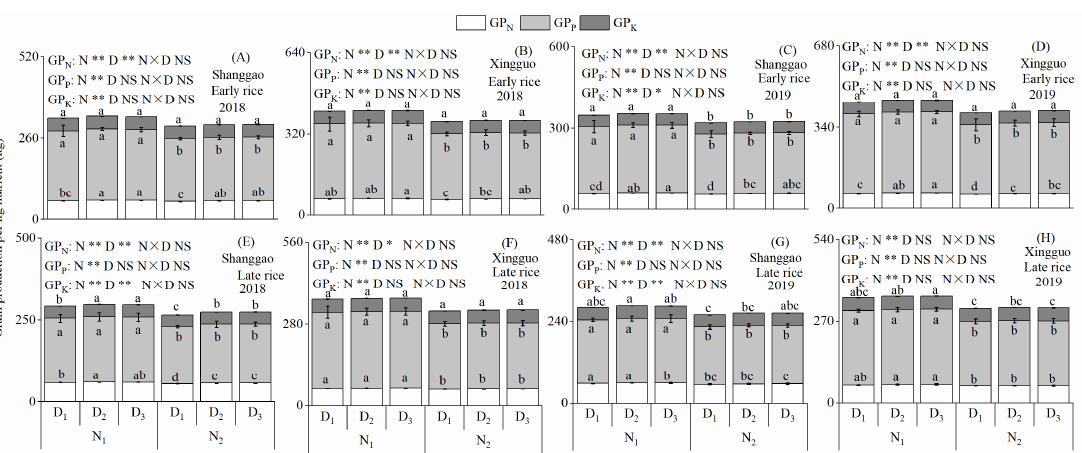
Figure 2. GP N , GP P and GP K of double cropping rice ( A – H ) response to the nitrogen (N) rate and plant density in two different ecological regions in 2018 and 2019. N 1 and N 2 represent 120 and 150 kg ha -1 for early rice and N 1 and N 2 represent 120 and 165 kg ha -1 for late rice. D 1 , D 2 and D 3 represent 86, 143 and 200 plants per m 2 for early rice and D 1 , D 2 and D 3 represent 57, 114 and 172 plants per m 2 for late rice. Values followed by different lowercase letters are significantly different at the 0.05 level. NS, * and ** represent no significant difference and significant difference at the 5% and 1% levels.